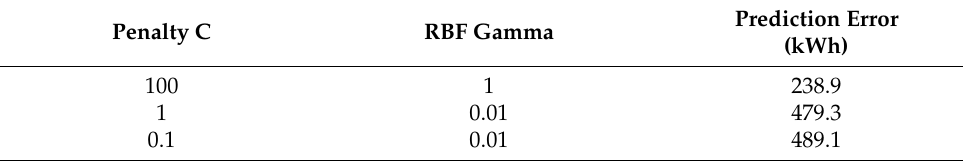
Table 2. Parameter tuning of PGPM based on SVR.